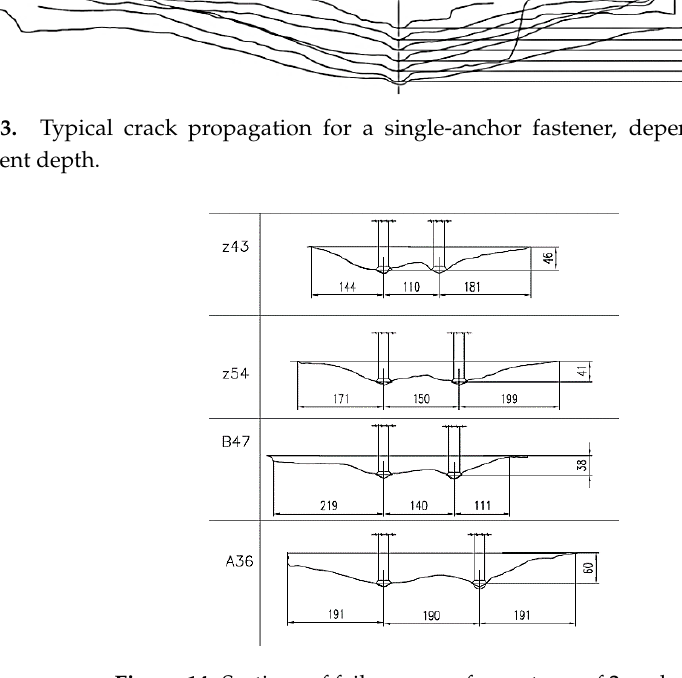
Figure 14. Sections of failure cones for systems of 2 anchors.